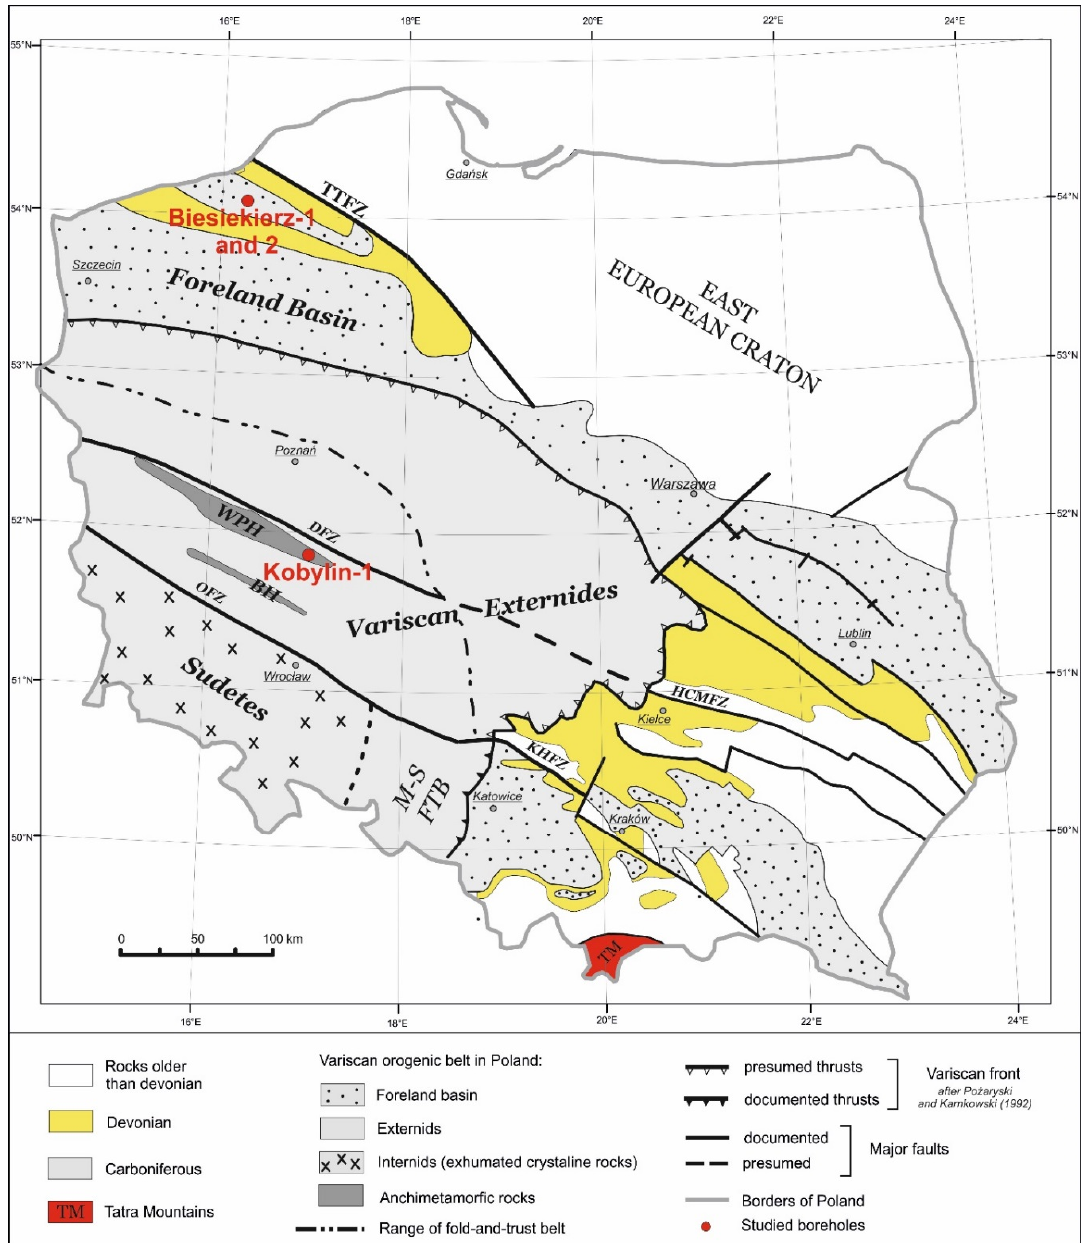
Figure 4. Location of boreholes selected for research against the map of Carboniferous rock range (after Żelaźniewicz et al. [23]).